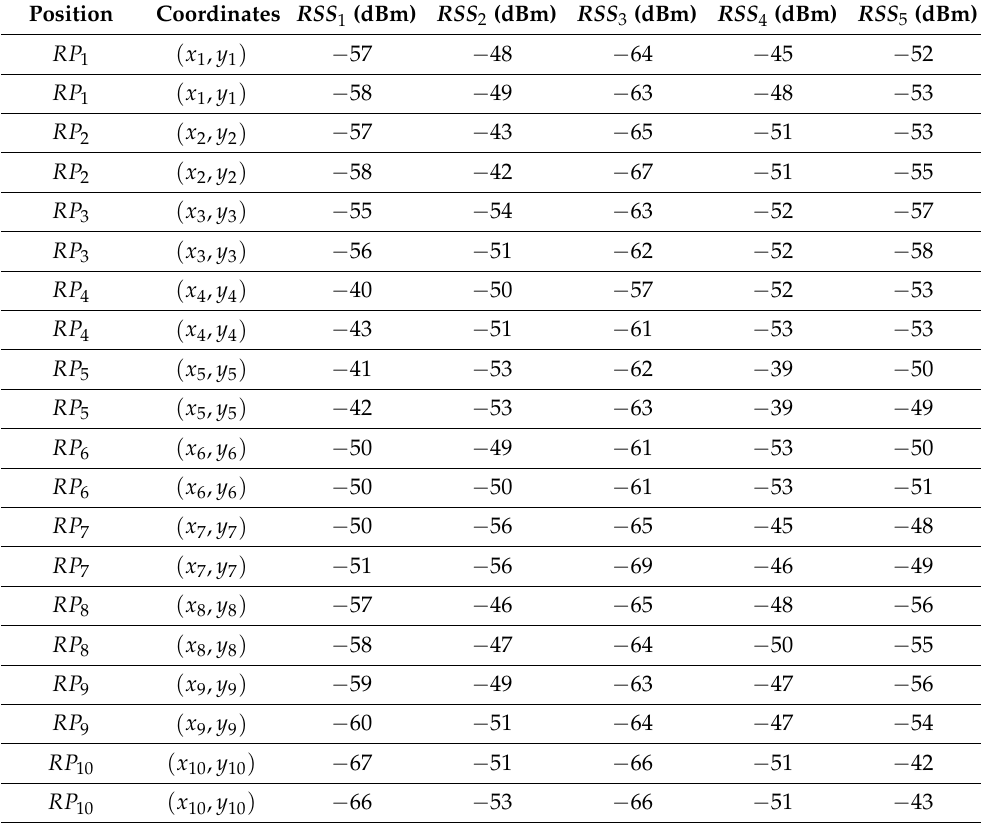
Table A1. The original RSS database proposed for the example.